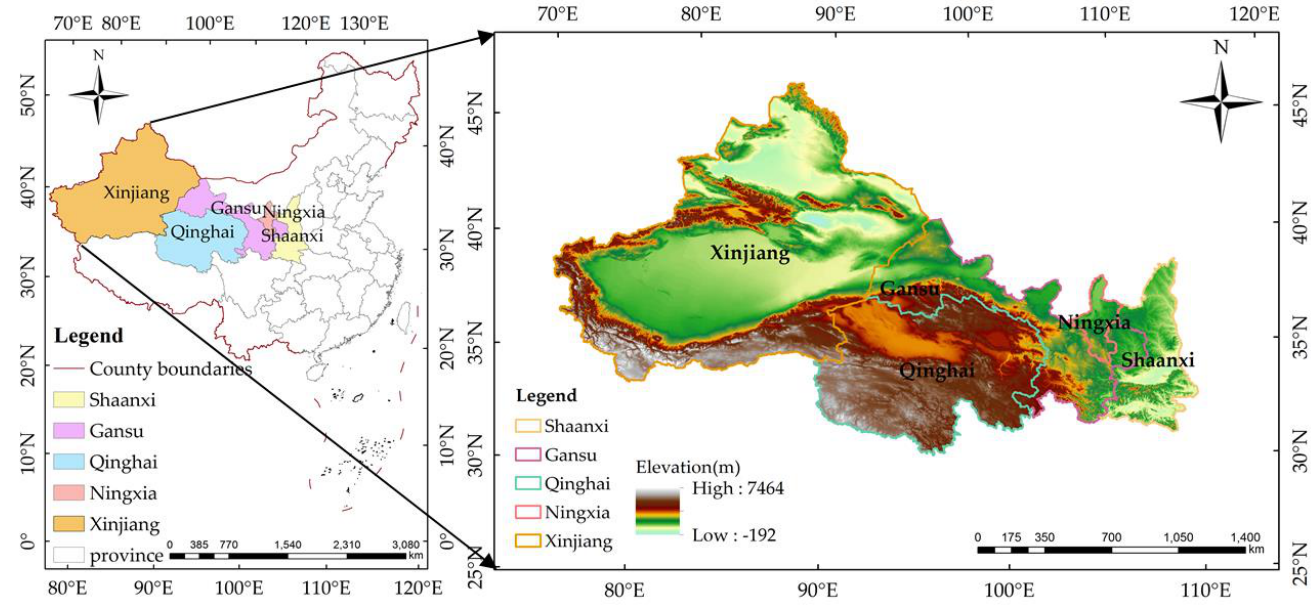
Figure 1. Study area of Northwest China.